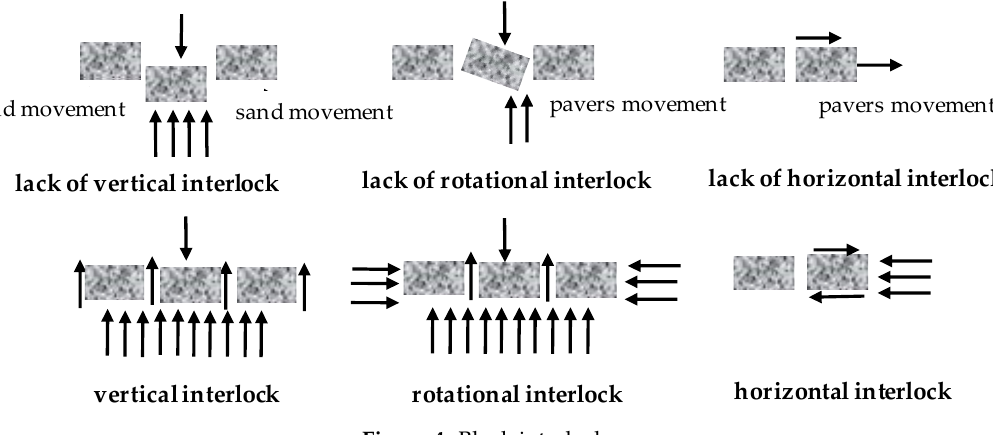
Figure 5. Block patterns. Permeable interlocking concrete pavers are elements that can be laid out in an interlocking grid pattern, with in-between spaces commonly filled with grass or small stones. Even nonpermeable blocks can ensure interesting values for permeable surfaces (Figure 6): up to an 18% permeable surface can be achieved by varying the block pattern and the position of the paving spacers. The stretcher (or running) bond and staggered stretcher (or running) bond provide the best performances.